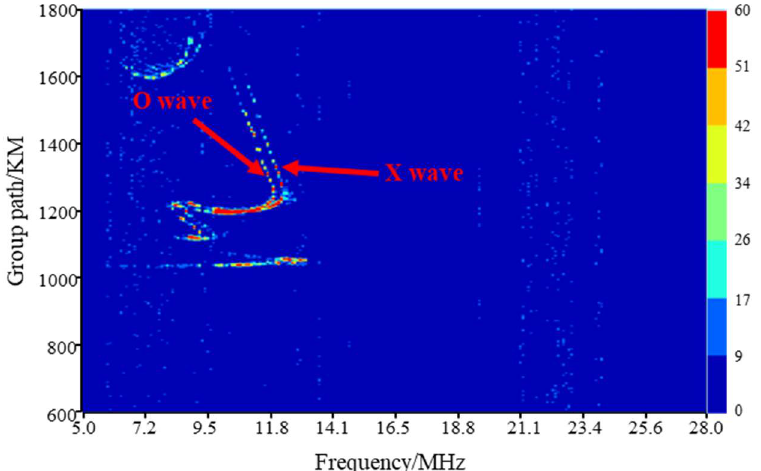
Figure 1. An example of an ionization map in ionospheric passive oblique detection.